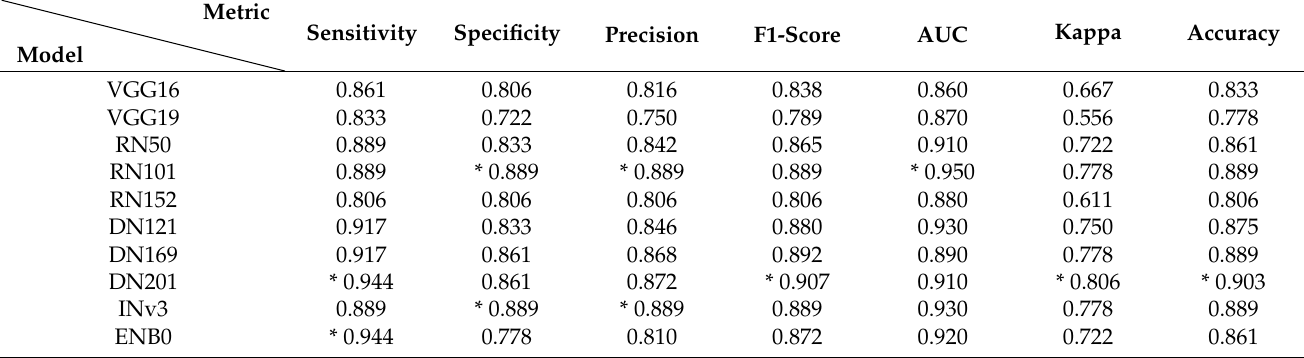
Table 8. Effectiveness of compared CNNs with transfer learning for different